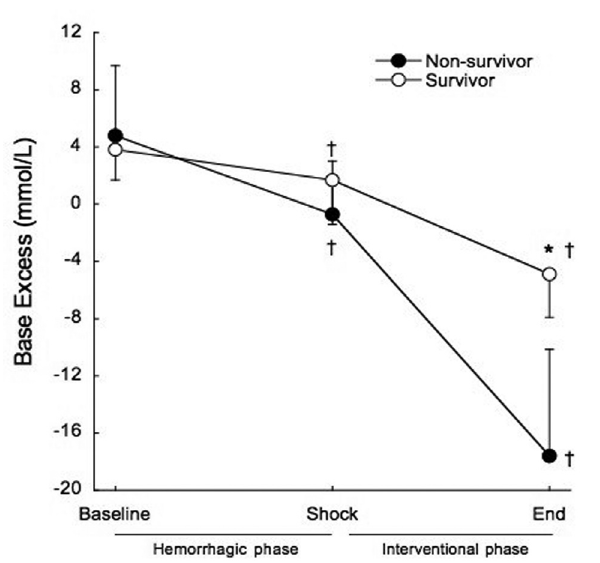
Figure 5 - Mean base excess before treatment at hemorrhagic phase (base- line and shock), and after treatment at the end of the interventional phase, in survivors (open circles) and non-survivors (filled circles). † p <0.01 when compared to baseline. * p <0.001 when compared to non-survivors.